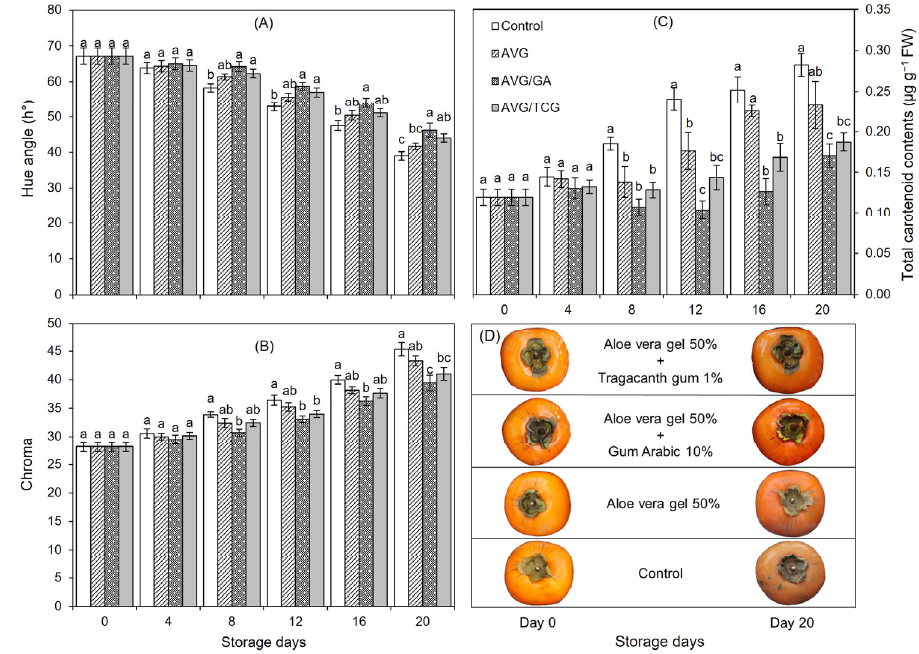
Figure 2. Effect of AVG-based composite coatings on hue angle ( A ), chroma ( B ) total carotenoid contents ( C ) and appearance ( D ) of persimmon fruits during 20 days storage (analysis on day 0, 4, 8, 12, 16 and 20) at 20 ± 1 °C and 80–85% relative humidity. All standard error bars are centered on means (3 biological replicates). Graph bars sharing same letters on a storage interval have non ‐ significance difference according to the LSD test at p ≤ 0.05.